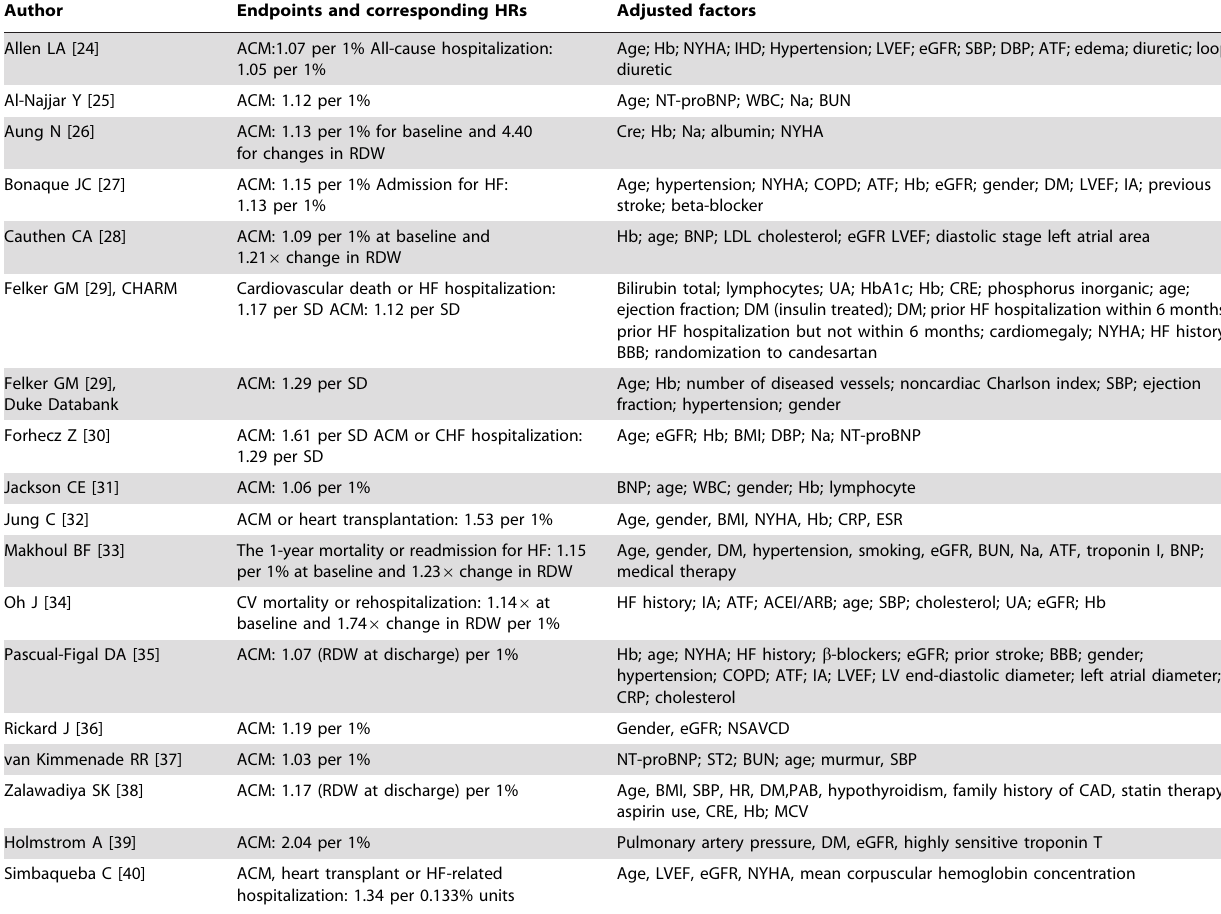
Table 2. Main findings of the eligible